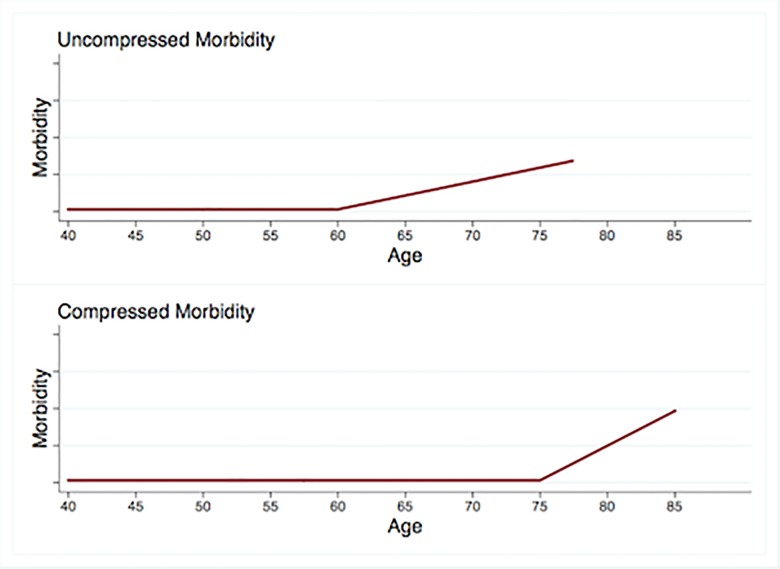
Compression of morbidity.Relative to the top trajectory, the bottom trajectory shows a 15-year delay in morbidity onset and a 7.5-year delay in death. Because the morbidity onset delay exceeds the delay in age of death, the morbidity period shown in the lower trajectory is compressed.